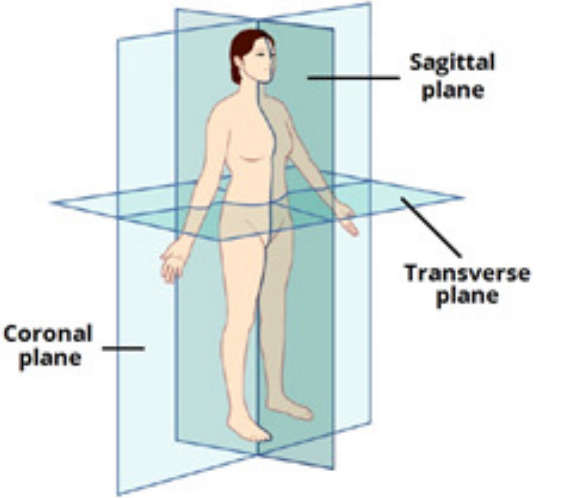
Figure 1. Planes or types of cuts obtained by MRI. Source: